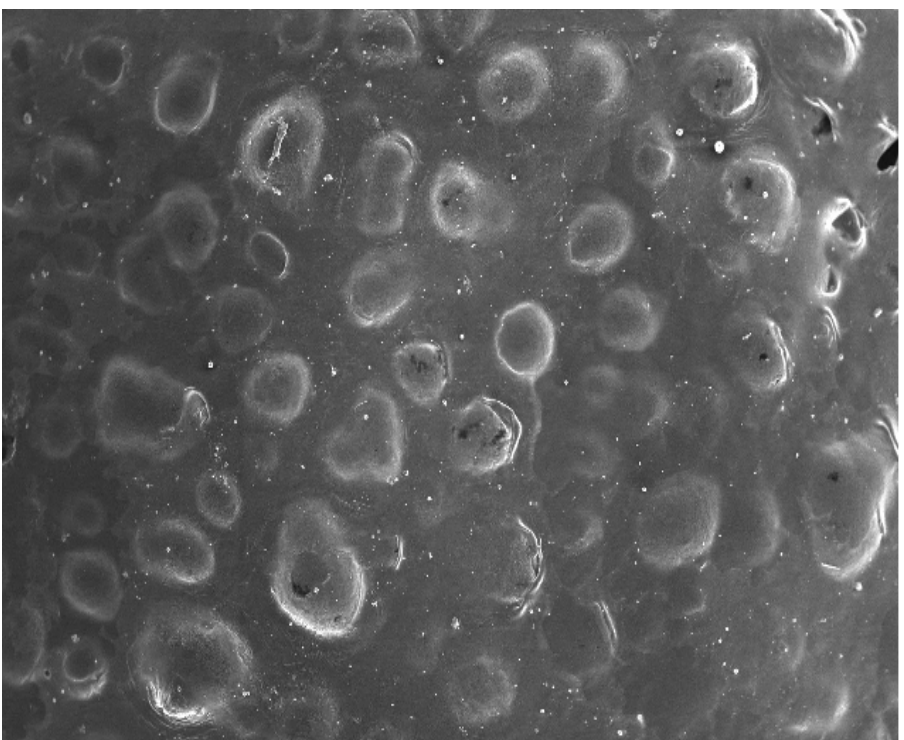
Figure 5. SEM photograph of EZL ‐ PNsopt.